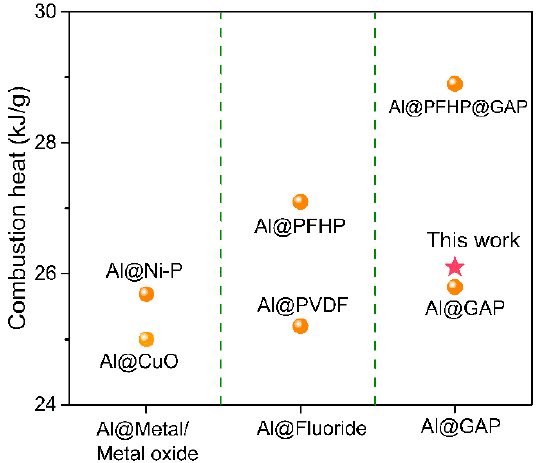
Figure 8. The comparison of combustion heat of this work with other literatures (Al@Ni-P [37],